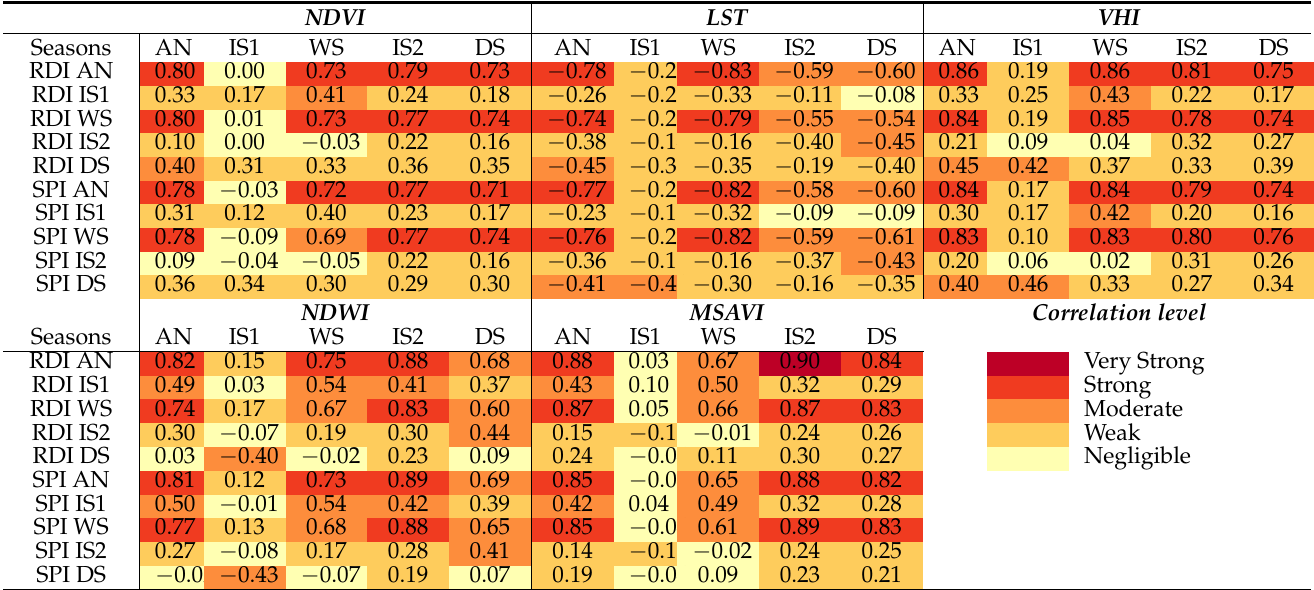
Table 4. Seasonal Pearson correlation coefficients (Annual, AN; Intervening Season 1, IS1; Wet Season, WS; Intervening Season 2, IS2; Dry Season, DS) for vegetation/water indices (Normalized Difference Vegetation Index, NDVI; Land Surface Temperature, LST; Vegetation Health Index, VHI; Normalized Difference Water Index, NDWI; Modified Soil Adjusted Vegetation Index, MSAVI) and meteorological drought indices (Reconnaissance Drought Index, RDI; Standardized Precipitation Index, SPI) in the Guadalupe Valley Basin, Baja California, Mexico. p -Value < 0.01 for all cases.